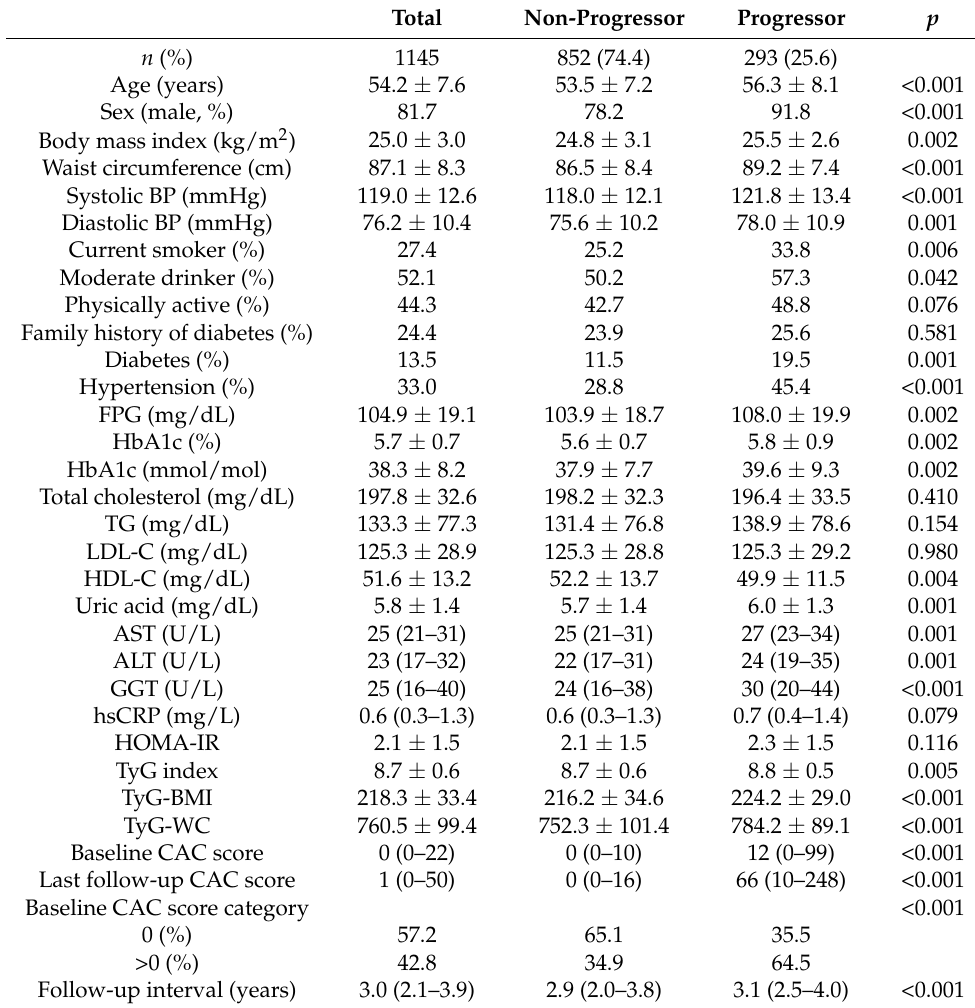
Table 1. Baseline clinical and biochemical characteristics according to the coronary artery calcification (CAC) score progression in the final cohort ( n =